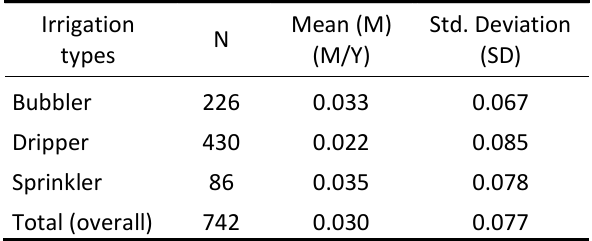
Table 4: Means and standard deviations of tree irrigation types to palm tree trunk deformation (M/Y) Irrigation